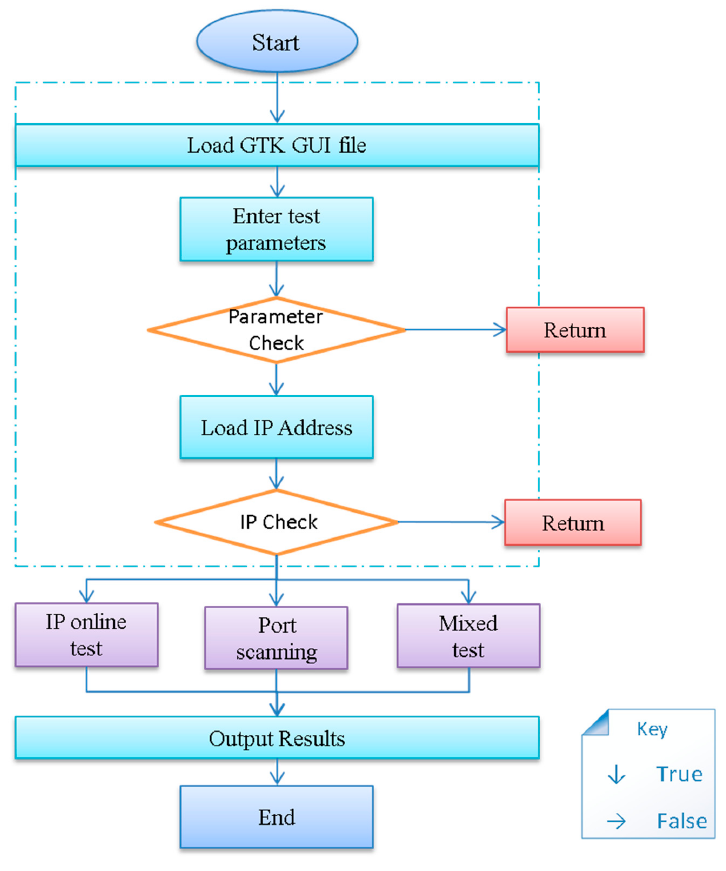
Figure 7. The flow chart of HIRFL Scanner.